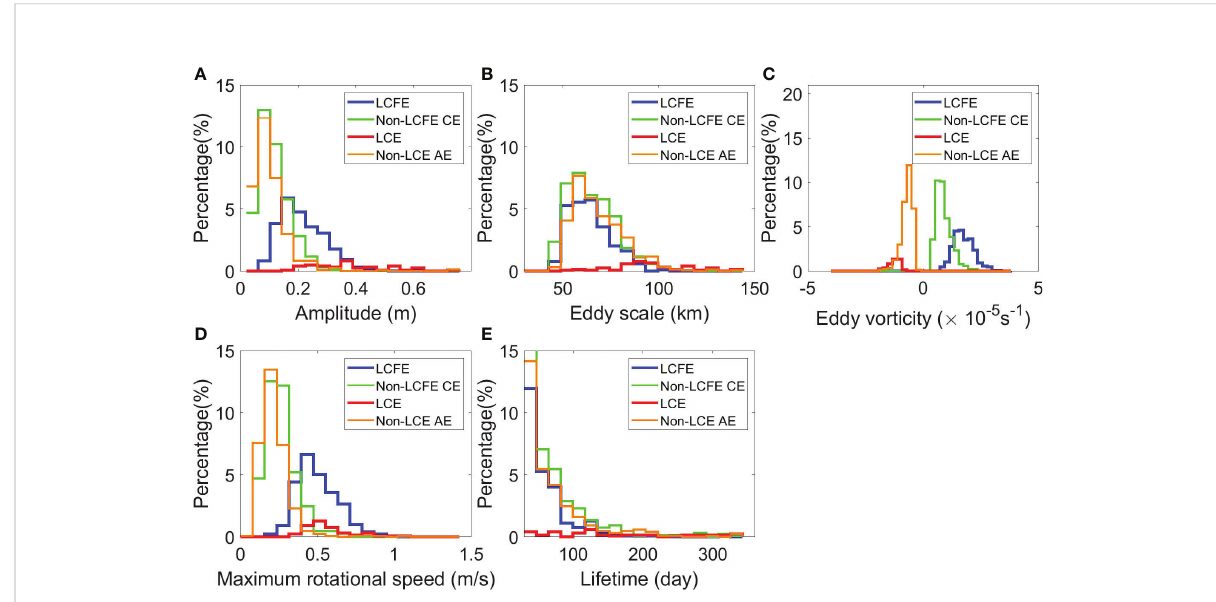
FIGURE 6 Histograms of basic eddy characteristics: (A) amplitude (m), (B) eddy scale (km), (C) eddy relative vorticity (s -1 ), (D) maximum rotational speed (m/s), (E) lifetime